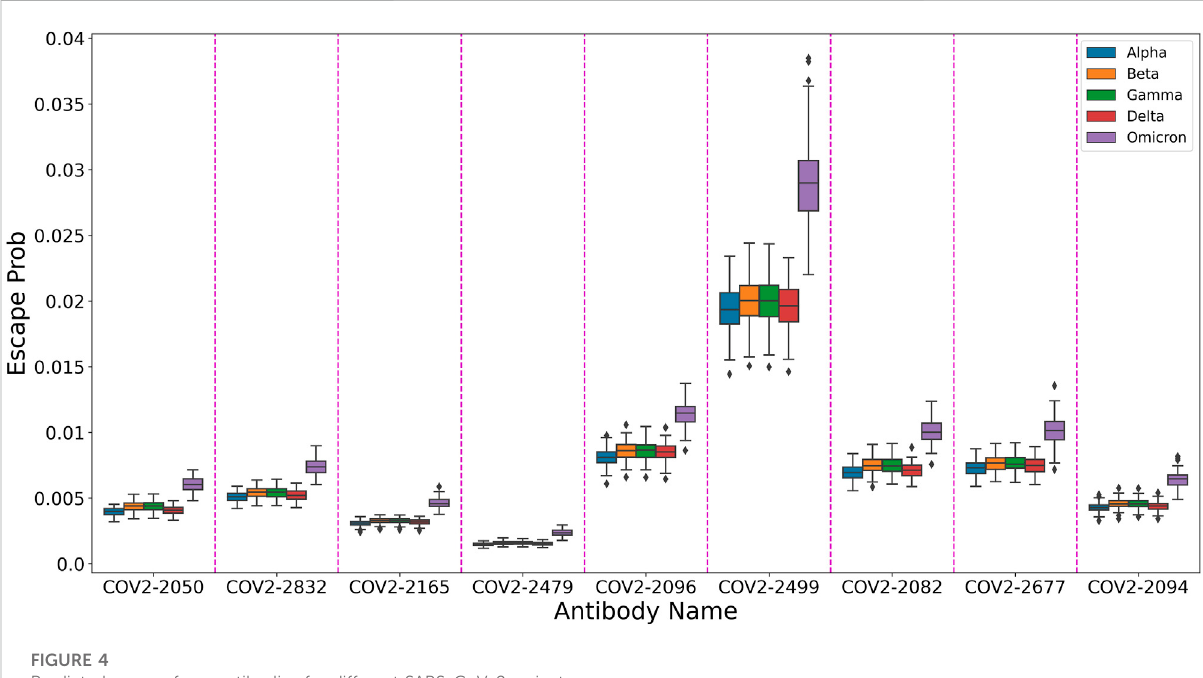
FIGURE 4 Predicted escape from antibodies for different SARS-CoV-2